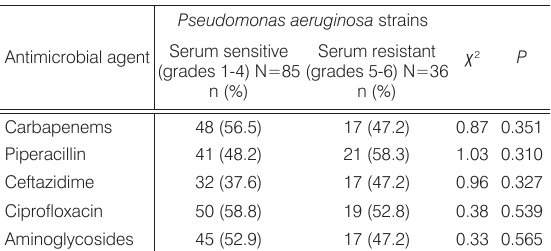
Table 2. Resistance of Serum Sensitive and Serum-Resistant Pseudomonas aeruginosa strains to Various Antibiotics.